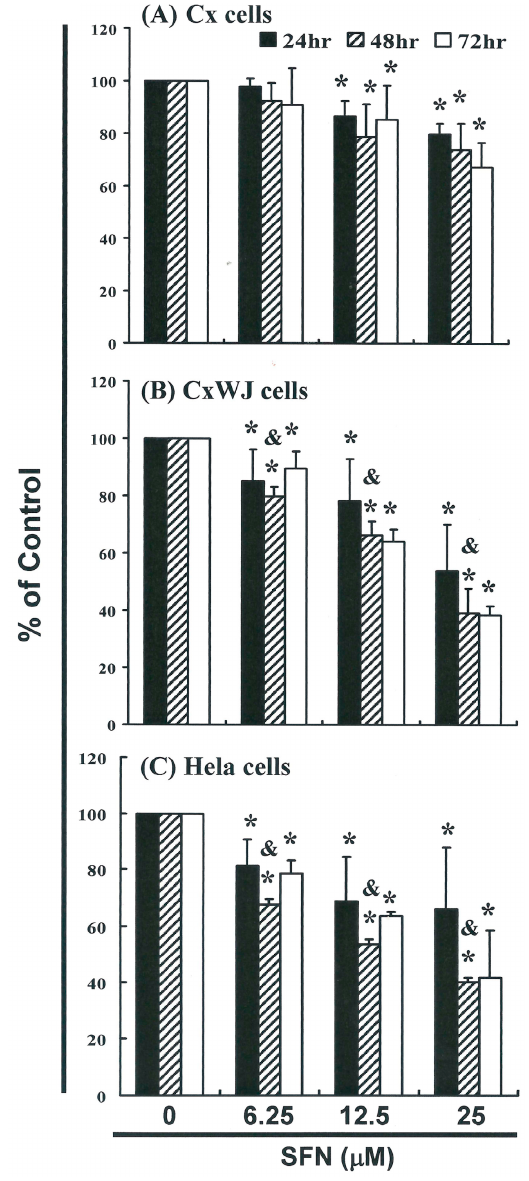
Figure 1. SFN inhibits the survival of cervical ( A ) Cx; ( B ) CxWJ and ( C ) HeLa cancer cell lines, thereby inhibiting proliferation. Cancer cell lines were treated with increasing doses of SFN (0, 6.25, 12.5 and 25 μ M) for 24 to 72 h, and cell survival was quantified using the MTT method. Results were expressed as a percentage of the control, which was considered to be 100%. All data are reported as the mean (±SEM) of at least three separate experiments. Statistical analysis was performed using a t -test, with differences considered significant at a level of p < 0.05. (The * symbol indicates that results were significant versus the control group, and the & symbol indicates that results were significant versus the 24 h group)